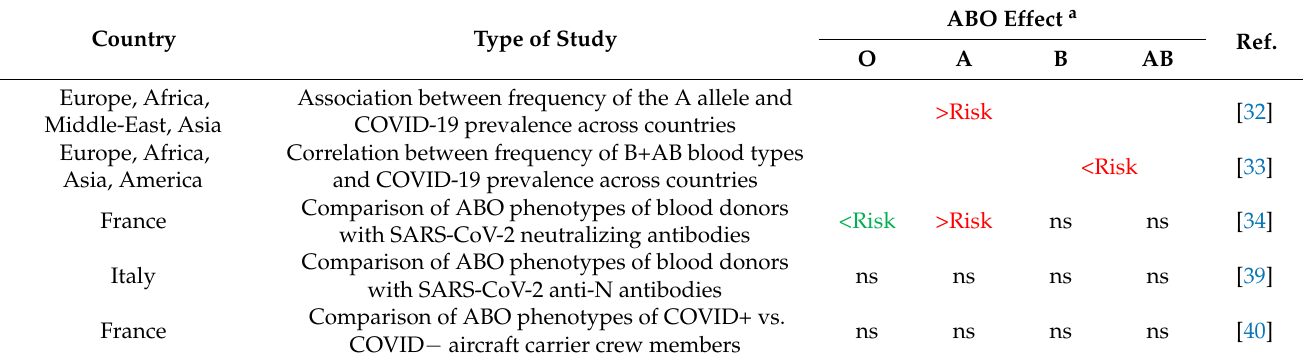
Table 3. Other study settings reporting data on ABO blood groups and COVID-19. Country